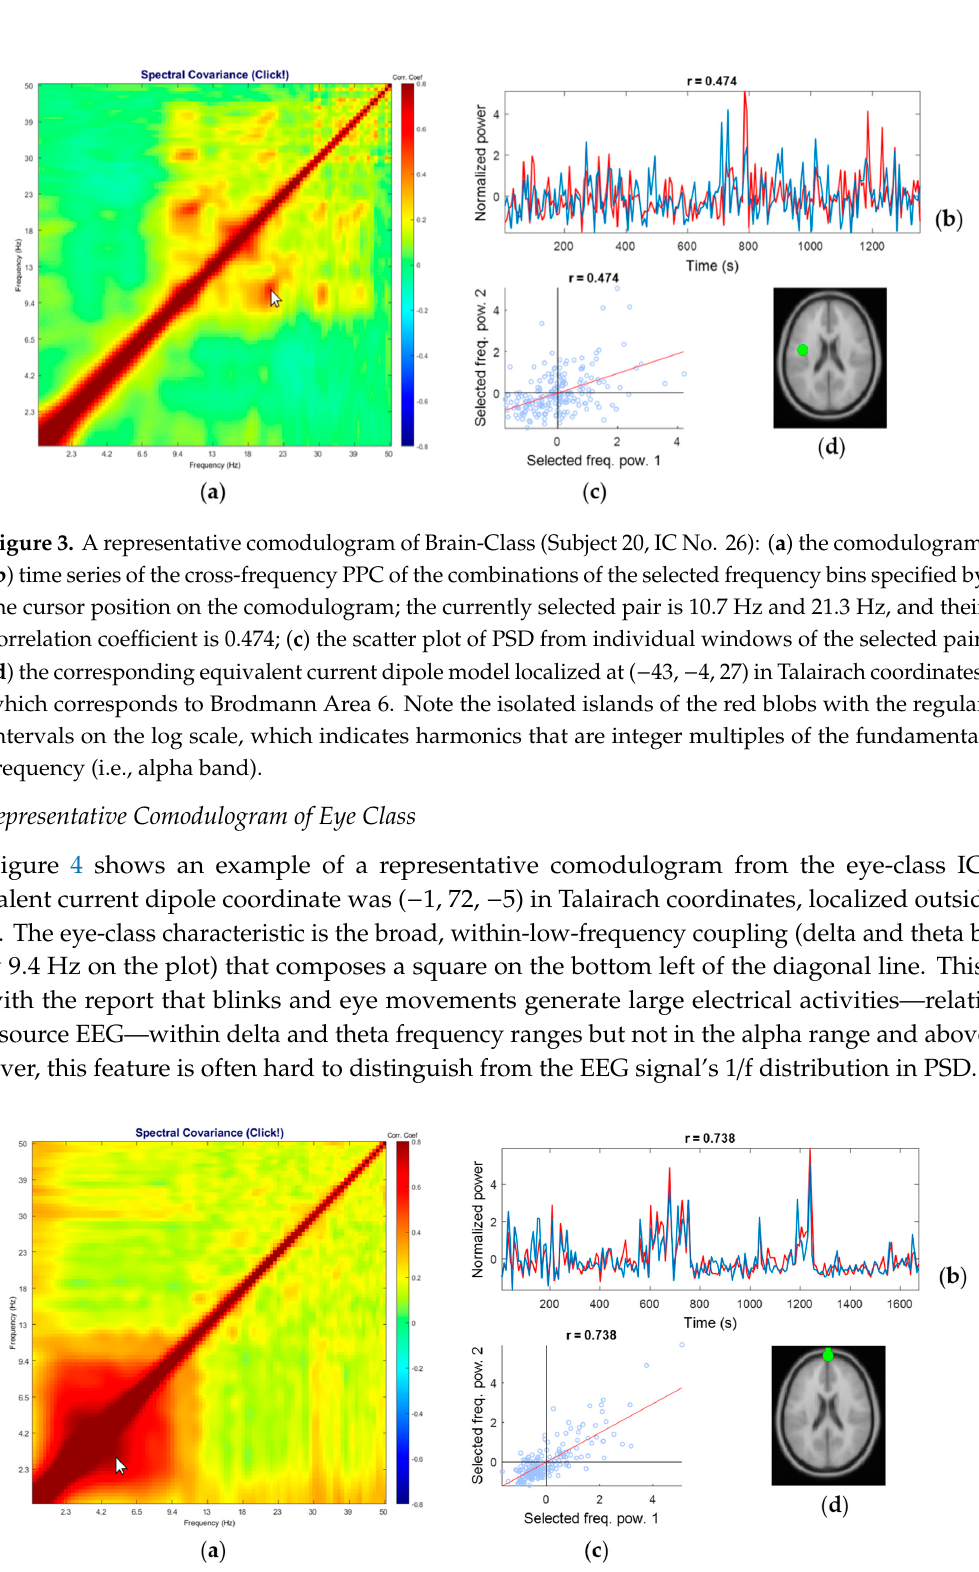
Figure 4. A representative comodulogram of Eye-Class (Subject 1, IC No. 1): ( a ) the comodulogram; ( b ) time series of the cross-frequency PPC of the combinations of the selected frequency bins specified by the cursor position on the comodulogram; the currently selected pair is 2.7 Hz and 5.3 Hz, and their correlation coefficient is 0.738; ( c ) the scatter plot of PSD from individual windows of the selected pair; ( d ) the corresponding equivalent current dipole model localized at ( − 1, 72, − 5) in Talairach coordinates, which identified as eye artifact.